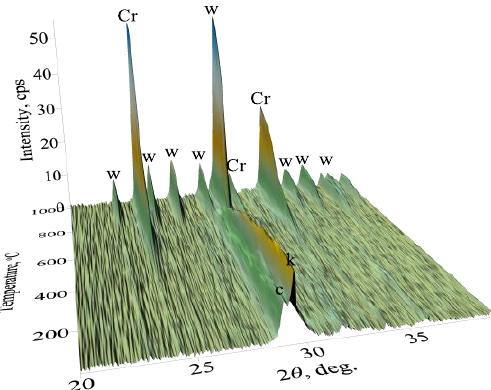
Figure 2. In-situ XRD patterns of synthesis products when the temperature of calcination is 25 – 1000 °C. Indexes: c – C-S-H(I)/C-S-H(II); w — wollastonite; k — CaCO 3 ; Cr — CaCrO 4 .